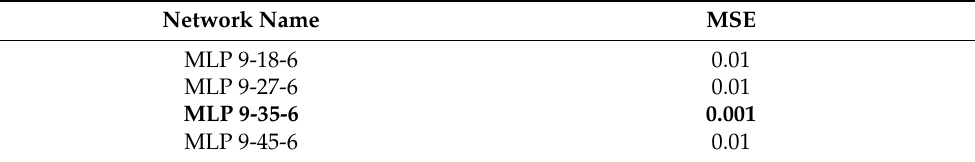
Table 6. (R)MSE values for three-MLP neural networks (bolded is the best).